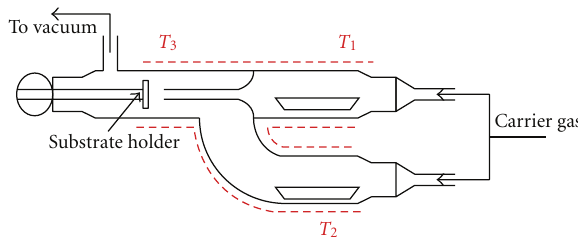
Figure 2: Three temperature zones RCVD reactor for thin films